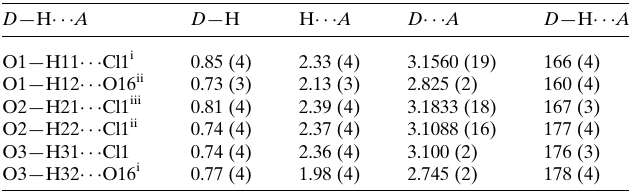
Table 1 Hydrogen-bond geometry (A˚ , (cid:5) ).